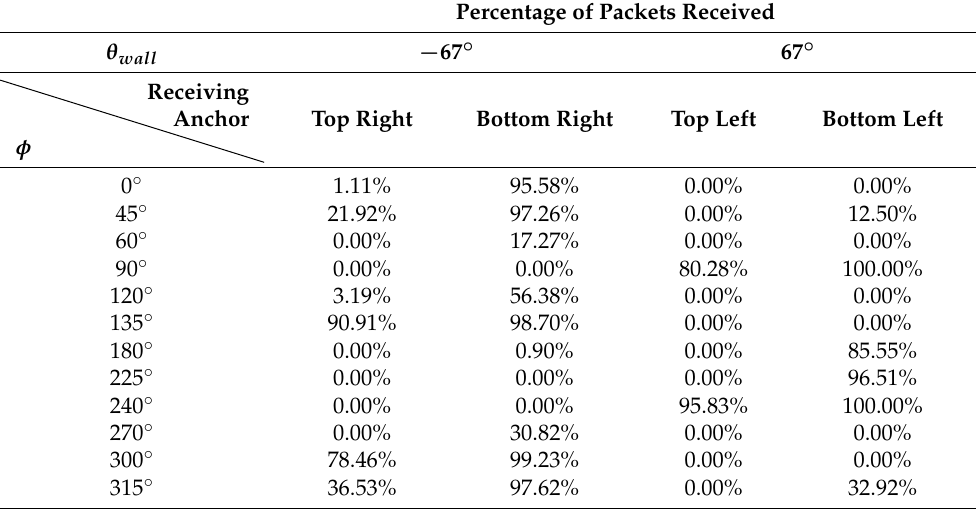
Table 5. Percentage of transmitted packets received by the two wall-mounted anchor nodes located in the opposite direction of the textile antenna’s broadside rotation for different body-deployment positions. With respect to the user’s anterior direction, the connectivity directions α represented by these wall anchors are given by α = φ − θ wall , as can be seen on Figure 9b. The table shows that no combination of fewer than 6 body-deployment locations φ can be found in which the node can make a reliable connection with the anchors deployed in all investigated elevation angles. Percentage of Packets